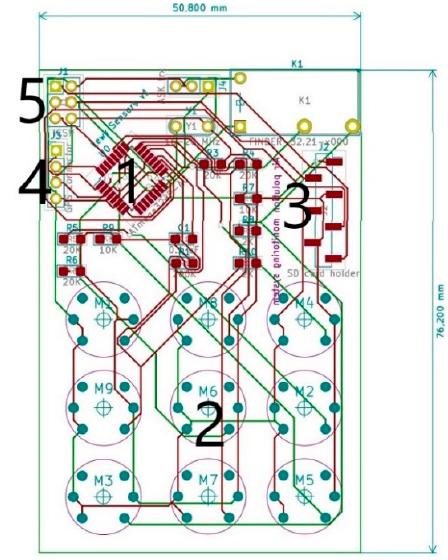
Figure 5. Schematic view of the first version of the integrated circuit board used for low-cost multisensory array assemble.